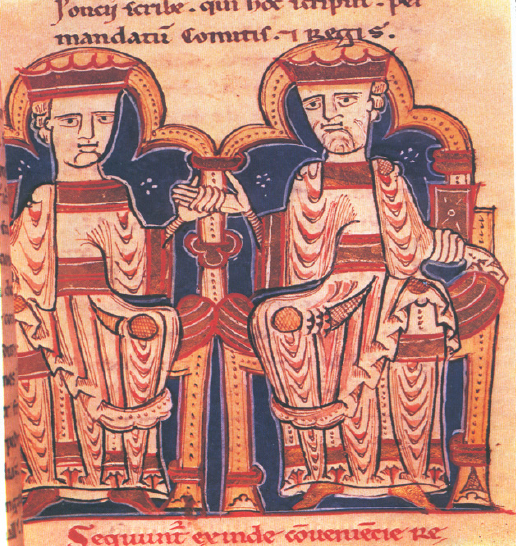
Figure 4. Liber Feudorum Maior . Canc. Reg. 1, Barcelona, Arxiu de la Corona d’Aragó ©. Fol. 19r. Alphonse II and Alphonse VIII of Castilla. End of the XII Century. Published by Magkanas et alii, Estudio de las miniaturas y del texto del Liber Feudorum Maior . Universitat de Barcelona: Barcelona, Spain, 2018, Figure 2.